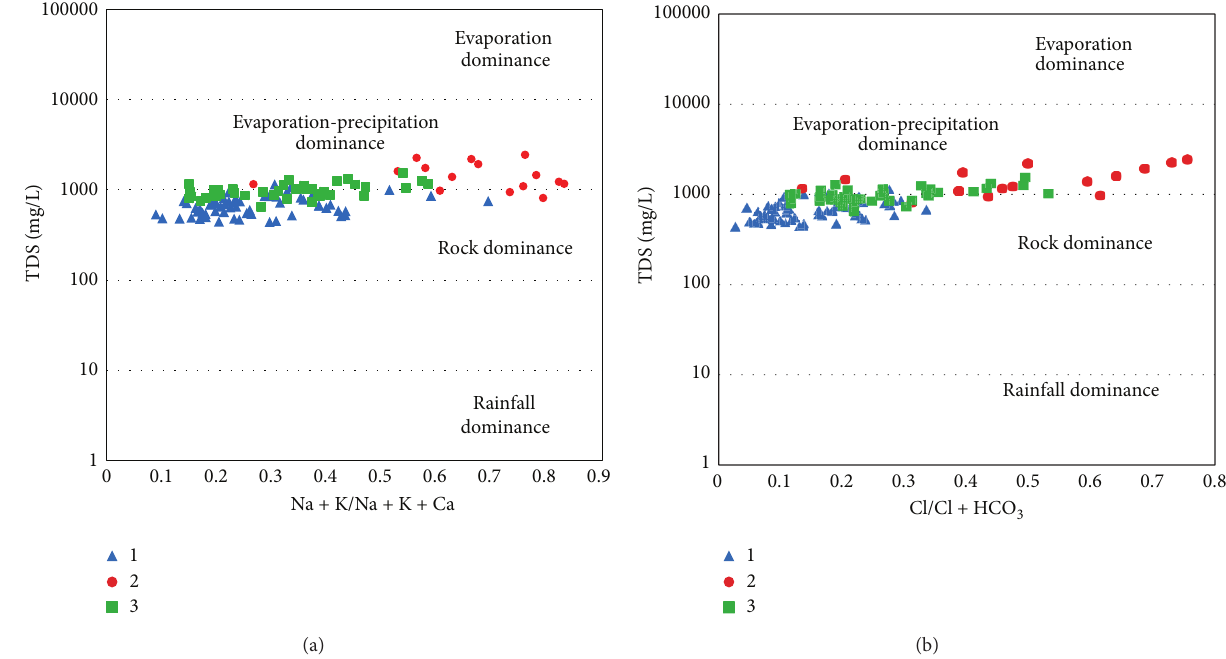
Figure 7: Gibbs plots explain groundwater chemistry and geochemical process in the study area.